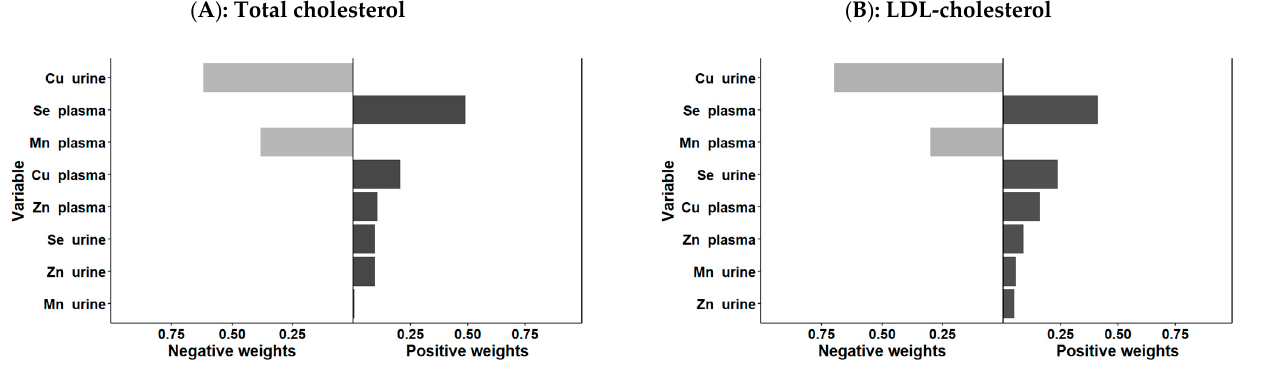
Figure 5. Overall mixture effect estimates and the weights for the plasma and urine trace elements (Zn, Cu, Se, and Mn) (psi1 beta coefficients, 95% confidence intervals (CI), and p -values) for the combined association of Zn, Cu, Se, and Mn with total cholesterol (panel A ) and LDL-cholesterol (panel B ) as continuous variables. Multivariable adjusted model.